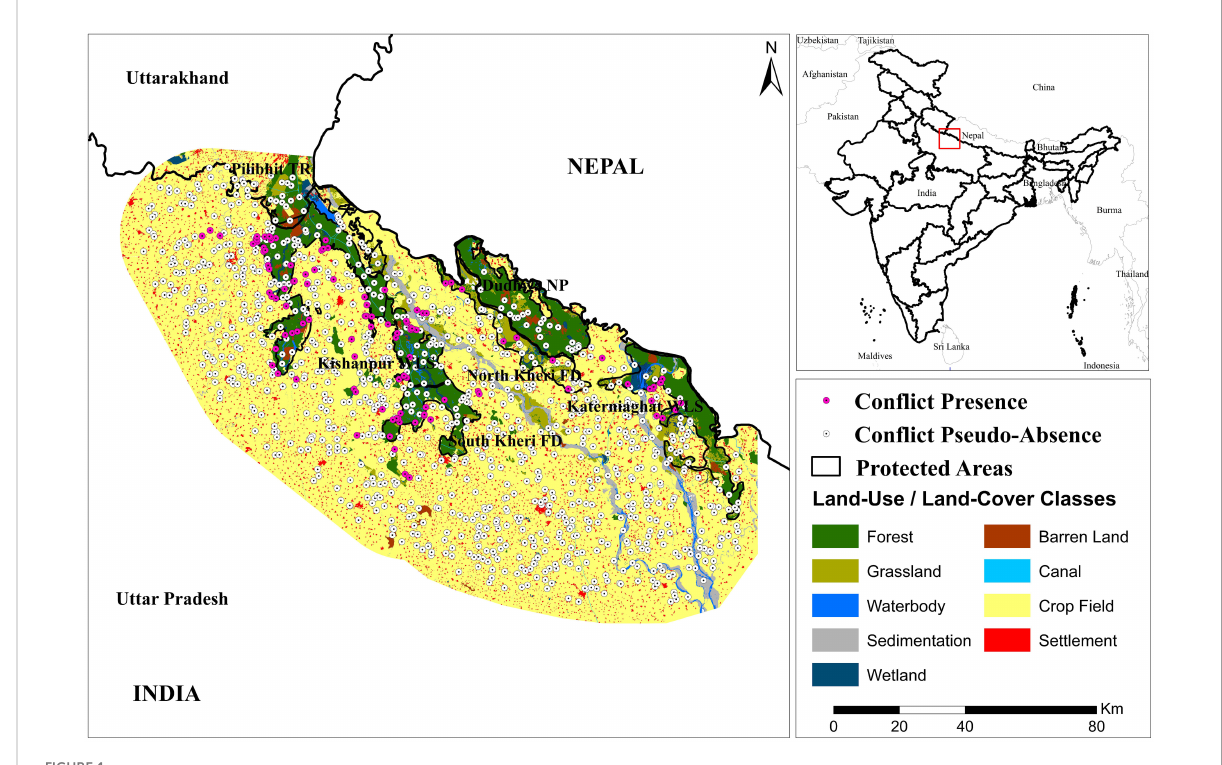
FIGURE 1 Study area with the presence and pseudo-absence locations of tiger attacks on humans. Inset: location of study area in